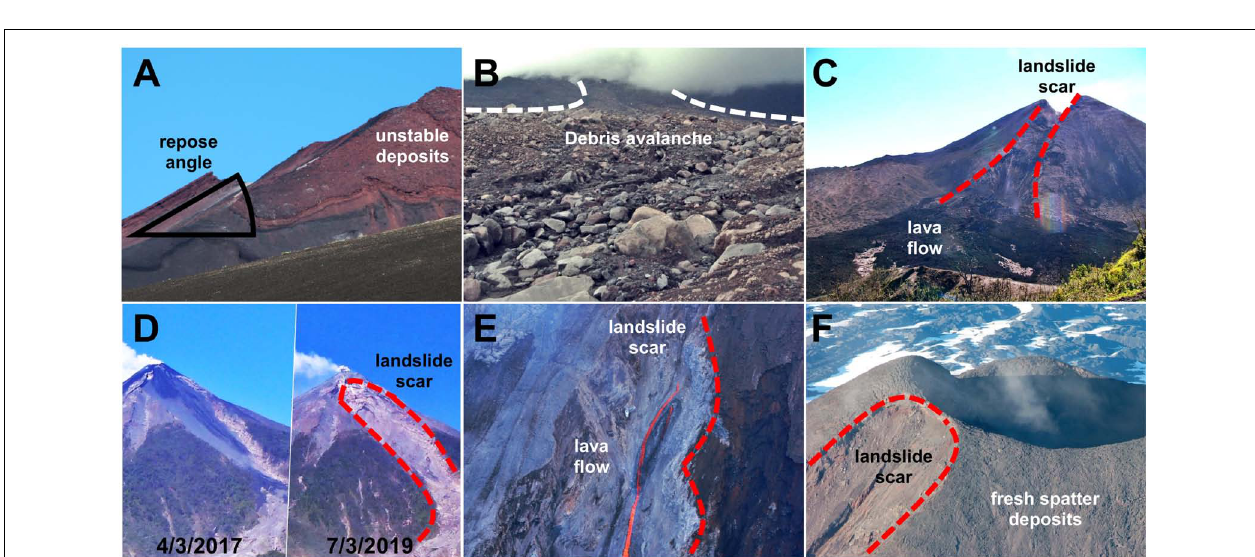
FIGURE 4 | Geomorphology of basaltic polygenetic volcanoes. (A) Belknap crater, a shield volcano (OR, United States). (B) Osorno stratovolcano (Chile). (C) Interbedded pyroclastic deposits and lava flows at Villarrica volcano (Chile). (D) Steep slopes of Llaima compound volcano (Chile). Photos by Jorge Romero.